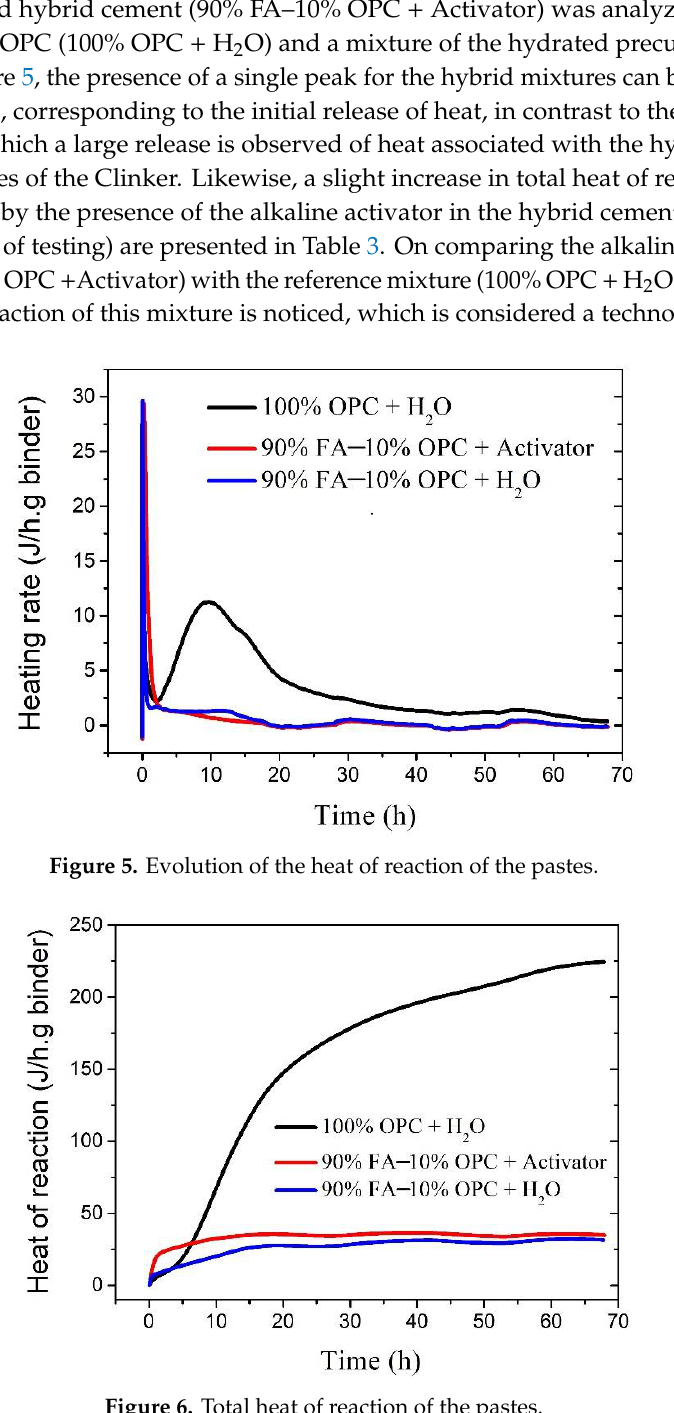
Figure 4. Effect of the molar ratios of Na/Si and Si/Al on the compressive strength (C.S.) of hybrid cement (paste) after 28 days of curing (C.S. 28d): the contours represent the strength levels.